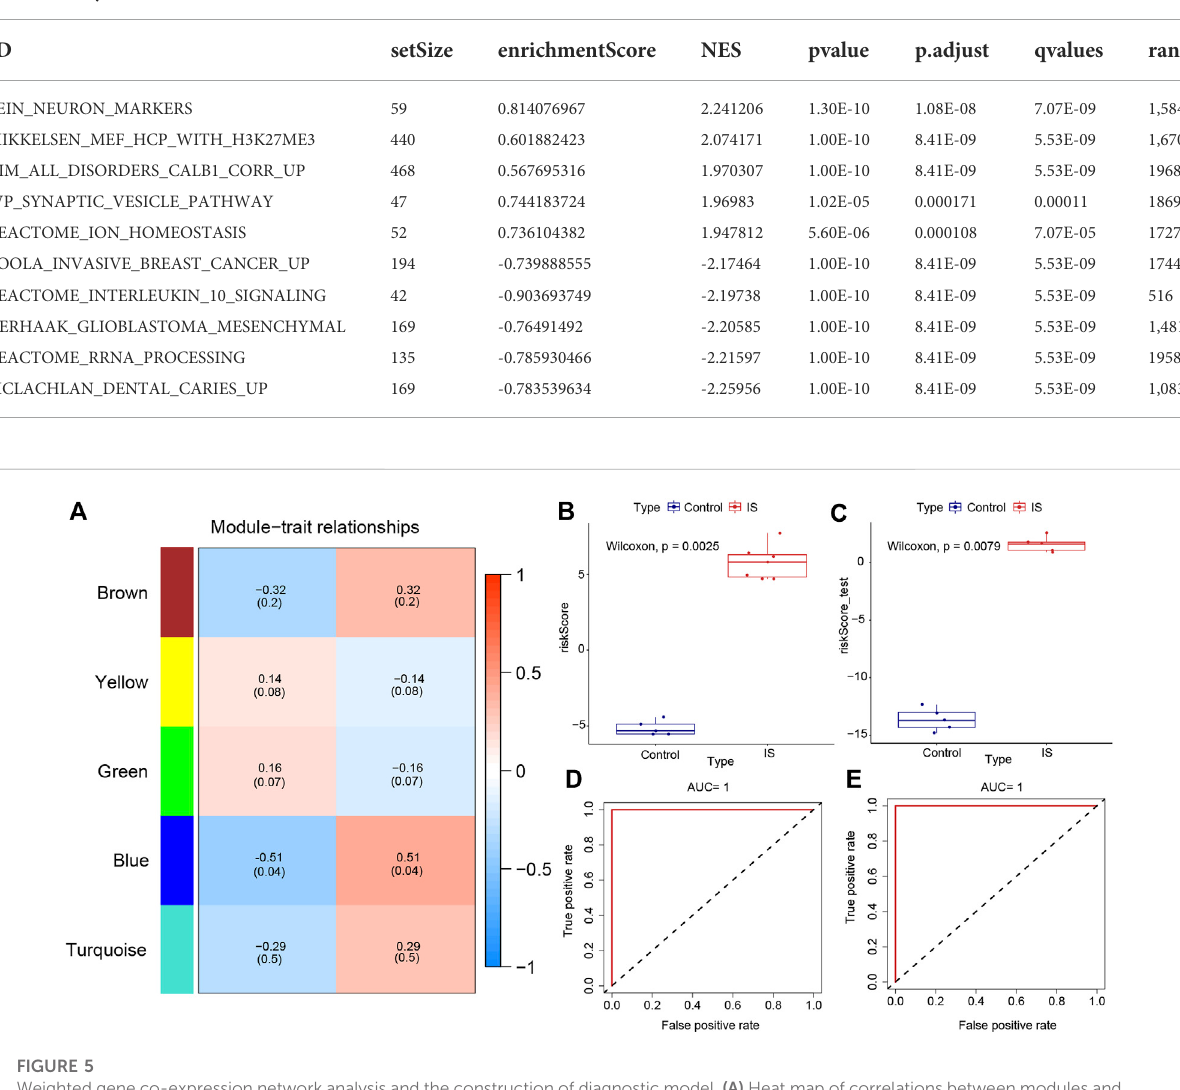
TABLE 3 GSEA analysis results.